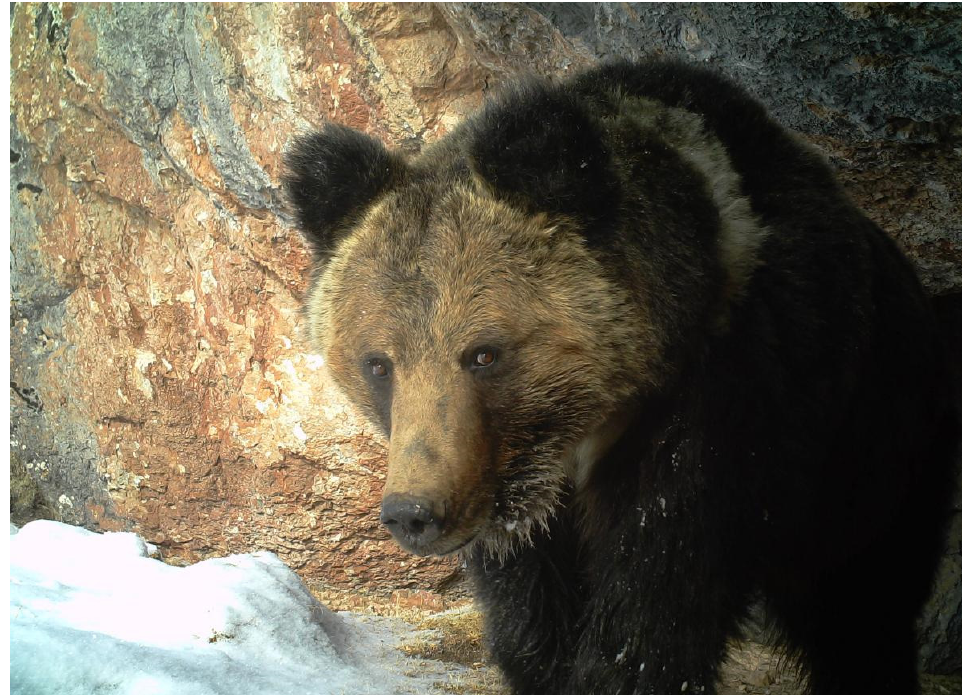
Figure 1. Tibetan brown bear ( Ursus arctos pruinosus ) captured by a camera trap in Sanjiangyuan National Park, China.